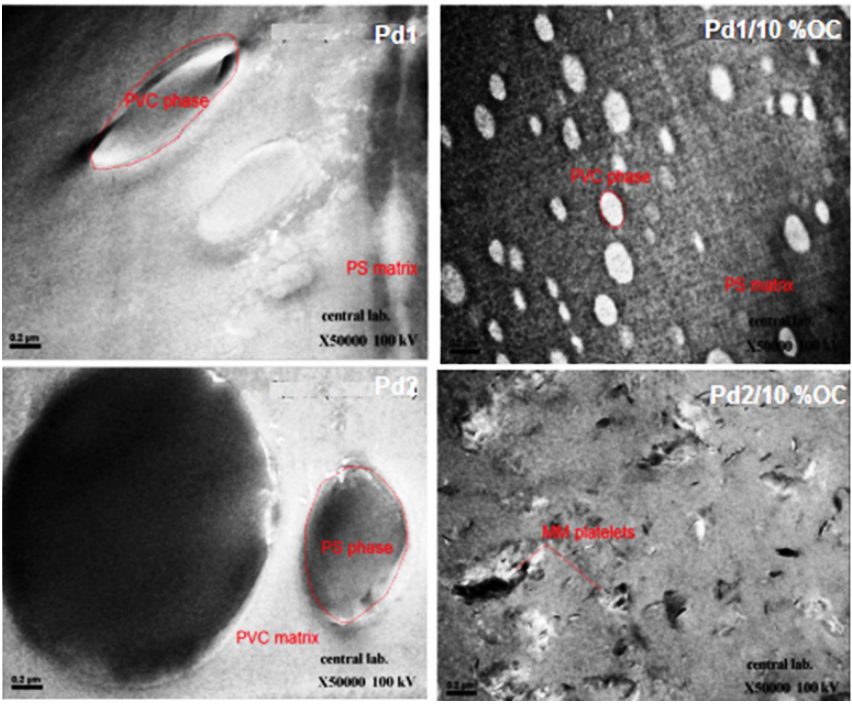
Figure 7: Transmission Electron Microscope(TEM) images of Pd1(PS/PVA:10/90), Pd1/10% Organoclay(OC), Pd2(PS/PVA:90/10) and Pd2/10% Organoclay(OC).